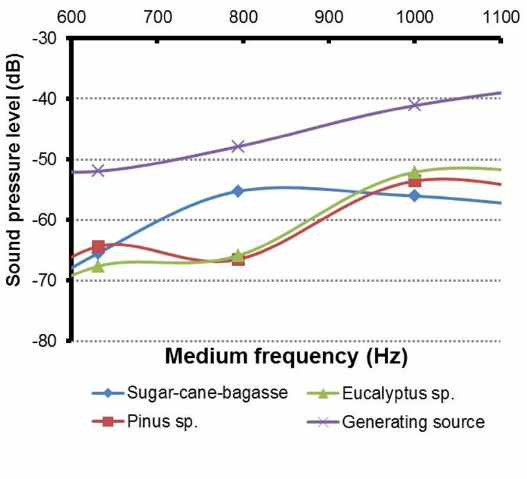
Figure 9. Levels of sound pressure for frequencies between 630 and 1,000